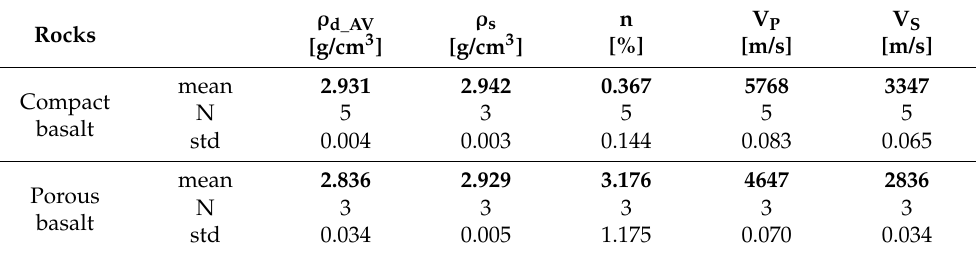
Table 2. Descriptive properties of the tested basalts: dried density ( ρ d_AV) , specific gravity ( ρ s ), porosity (n), P wave velocity (V P ), shear wave velocity (V S ). mean—average value, N—number of tests, std—standard